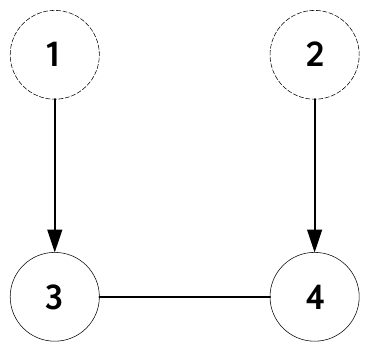
Figure 3. Structure of the multi-boiler system.